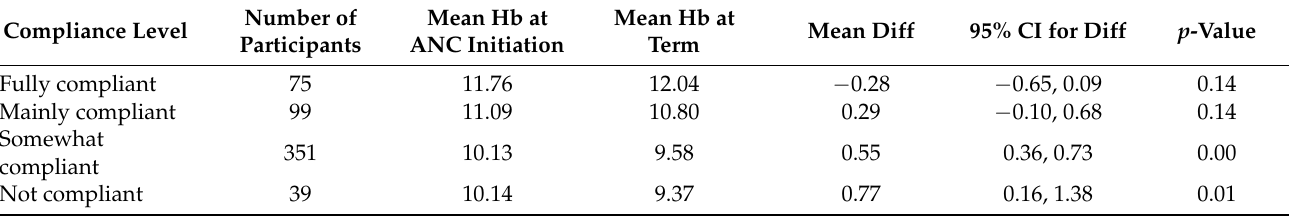
Table 4. Change in mean Hb for each level of compliance among 564